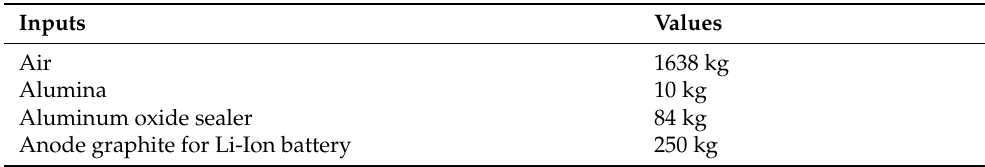
Table 7. The required material inputs to perform LCA analysis considering methanol as the SOFC’s fuel and R134a as ORC’s working fluid [36–38].